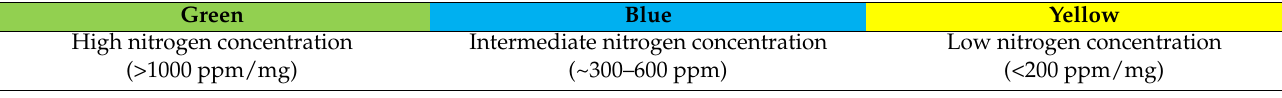
Table 4. Summary of the main results: FTIR, UV-Vis, fluorescence, and EPR for the color enhancement process to produce green, blue and yellow